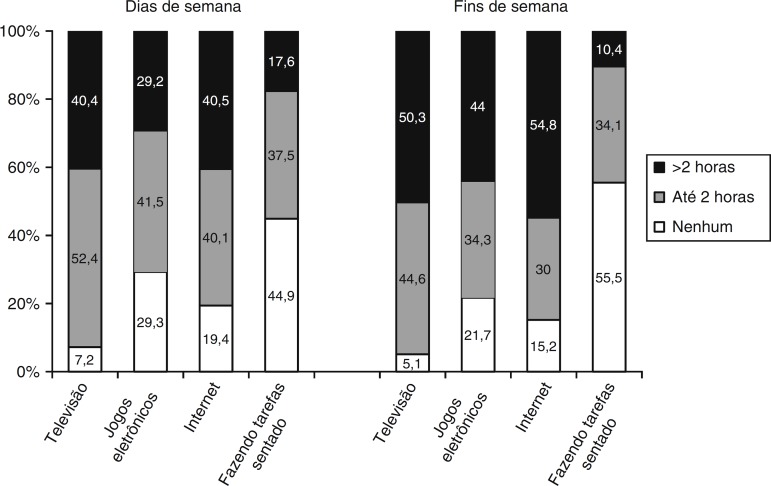
Comportamento sedentário dos estudantes em dias de semana e fins de
semana, Pelotas-RS Brasil, 2013, n=8.661.